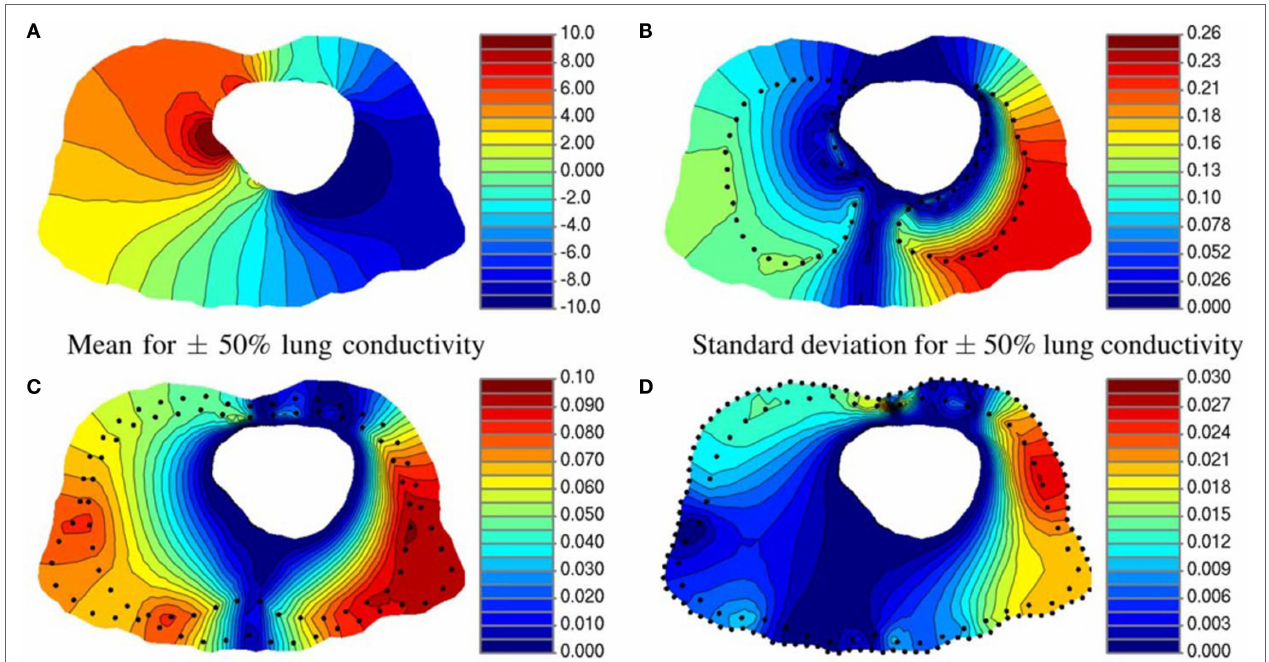
FIGURE 7 | Effect of tissue conductivity uncertainty of three organs on torso potential . (A) Mean and (B) standard deviation of the electrical potential resulting from varying the lung conductivity. Standard deviation of the potential distribution on torso for 50% variation in (C) muscle and (D) fat conductivity. All units are in millivolts. (Geneser et al.,